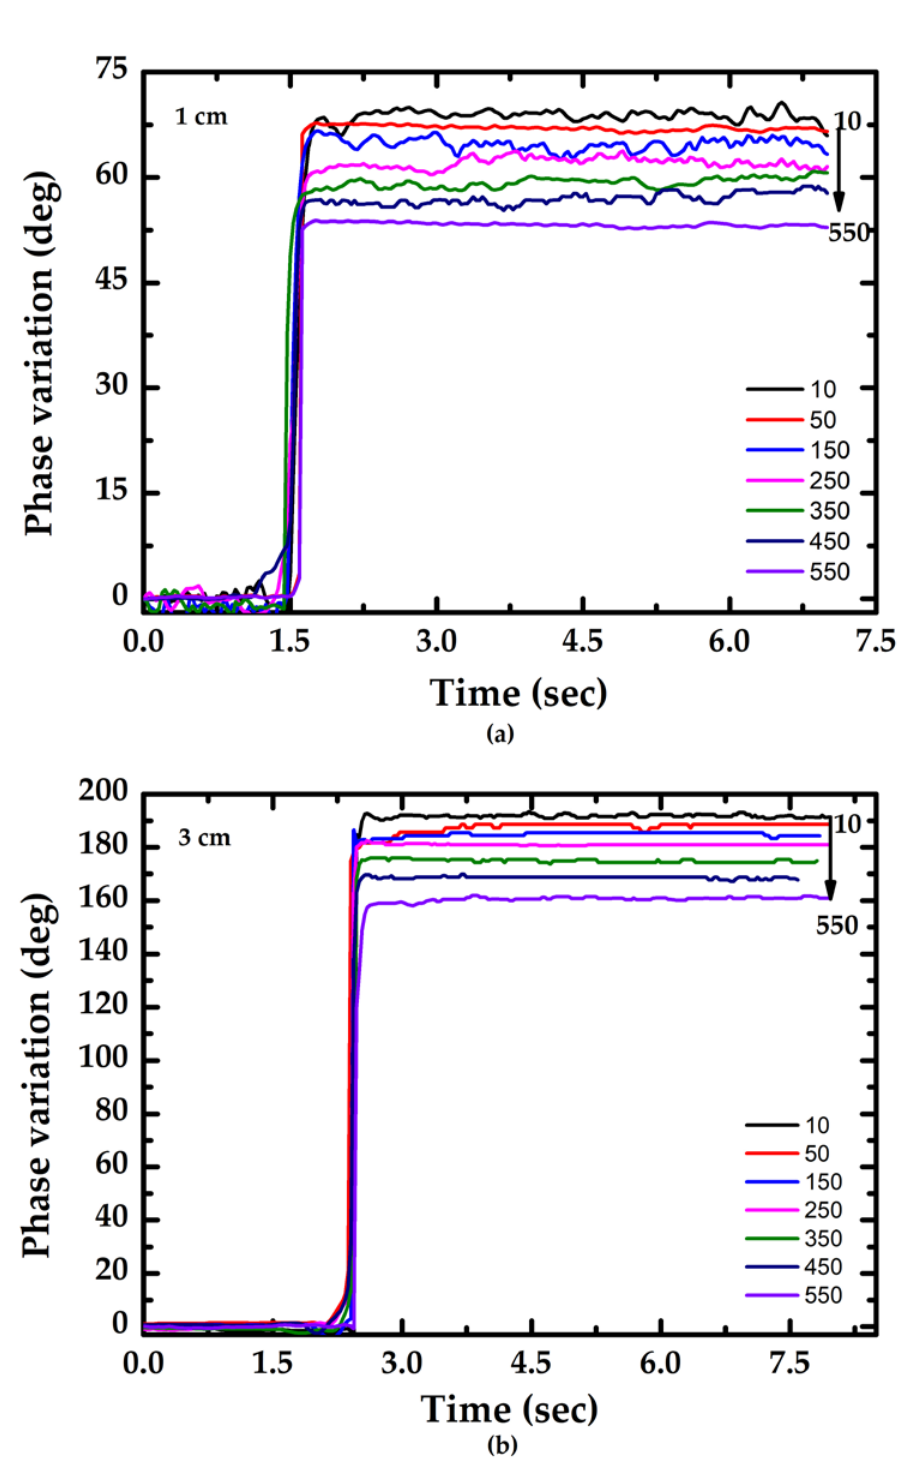
Figure 5. Phase–time response curves of the proposed sensor with various lengths: ( a ) L = 1 cm; ( b ) L = 3 cm.